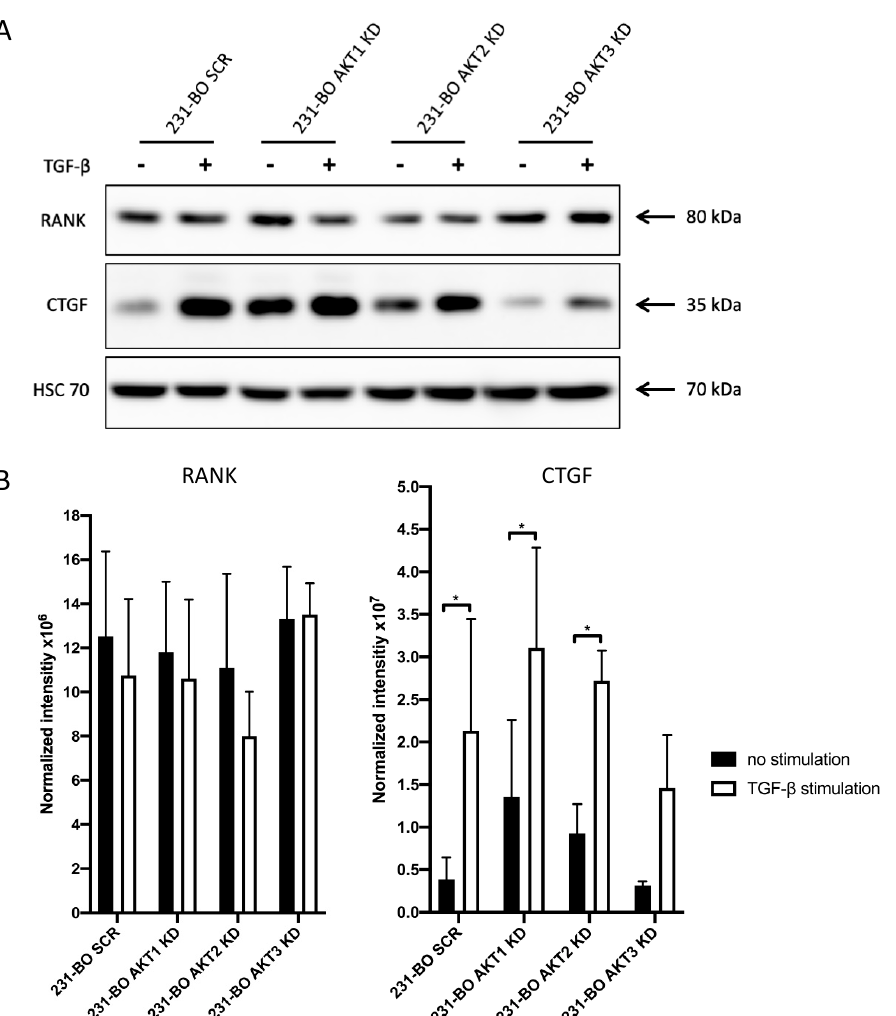
Figure 9. Knockdown of AKT3 in 231-BO cells results in a diminished increase in CTGF expression after TGF β -stimulation: ( A ) 231-BO cells with AKT isoform knockdowns were stimulated with 5ng/mL TGF β for 24 h prior to cell lysate preparation. Western blot analysis of vicious cycle associated proteins was performed using antibodies directed against the indicated proteins. HSC70 functions as a loading control. ( B ) Expression of CTGF and RANK indicated by the normalized intensity in the 231-BO AKT isoform knockdowns after TGF β -stimulation or without stimulation was quantified from Western blot analysis in triplicate. Data were normalized to Ponceau staining. Bars indicate mean with SD; * = p < 0.05.